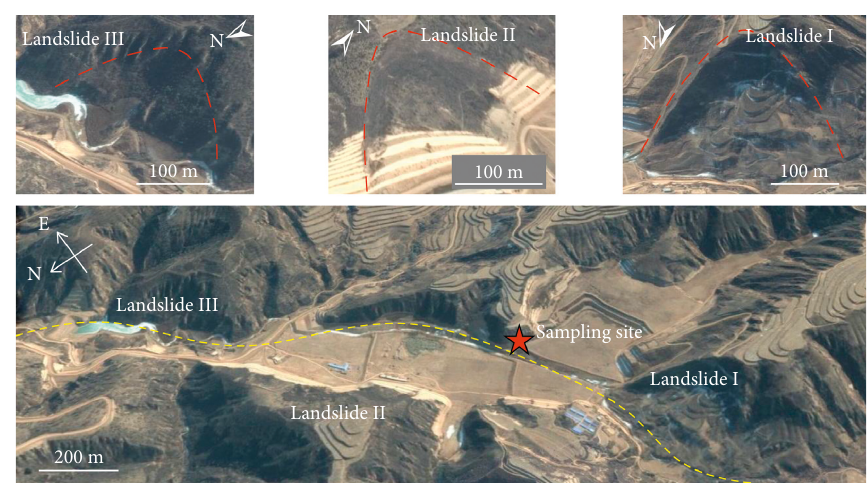
Figure 2: Distribution of landslides along fault zones.